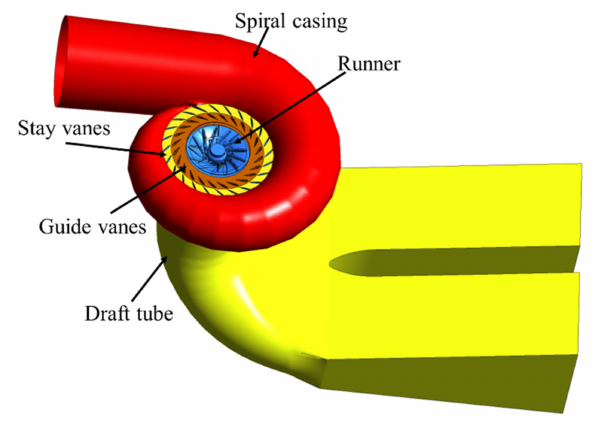
Figure 2. Model of numerical